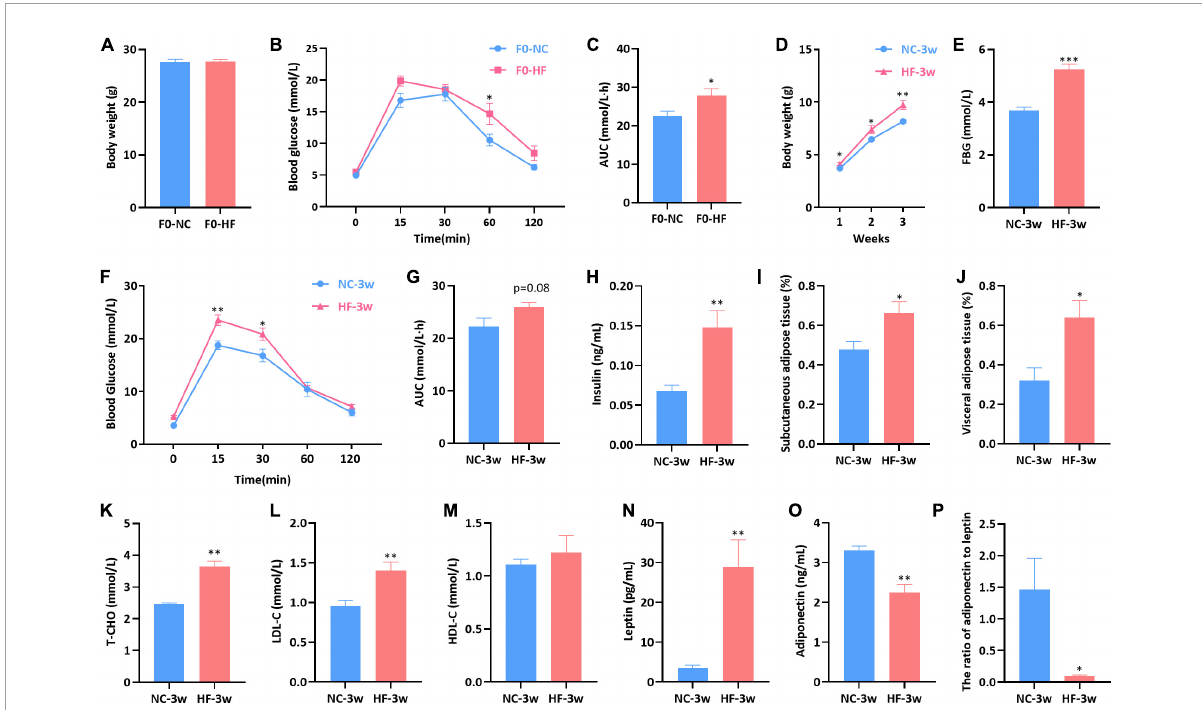
FIGURE1 Maternal HF diet impaired glucose metabolism in dams and damaged glycolipid metabolism in offspring at weaning. (A) Body weight of dams. (B) IPGTT of dams. (C) AUC of dams. (D) Body weight of offspring. (E) FBG of offspring. (F) IPGTT of offspring. (G) AUC of offspring. (H) Serum insulin of offspring. (I) Subcutaneous adipose tissue (%) of offspring. (J) Visceral adipose tissue (%) of offspring. (K) Serum T-CHO of offspring. (L) Serum LDL-C of offspring. (M) Serum HDL-C of offspring. (N) Serum leptin of offspring. (O) Serum adiponectin of offspring. (P) Ratio of adiponectin to leptin of offspring. Data are represented as mean ± SEM (F0-NC, n = 7; F0-HF, n = 8; NC-3w, n = 5–7; HF-3w, n = 6–7). ∗ p < 0.05, ∗∗ p < 0.01, ∗∗∗ p < 0.001 vs. F0-NC, NC-3w. NC, normal chow diet; HF, high-fat diet; IPGTT, intraperitoneal glucose tolerance tests; AUC, the area under the glucose curve; FBG, fasting blood glucose; T-CHO, total cholesterol; LDL-C, low-density lipoprotein cholesterol; HDL-C, high-density lipoprotein cholesterol.